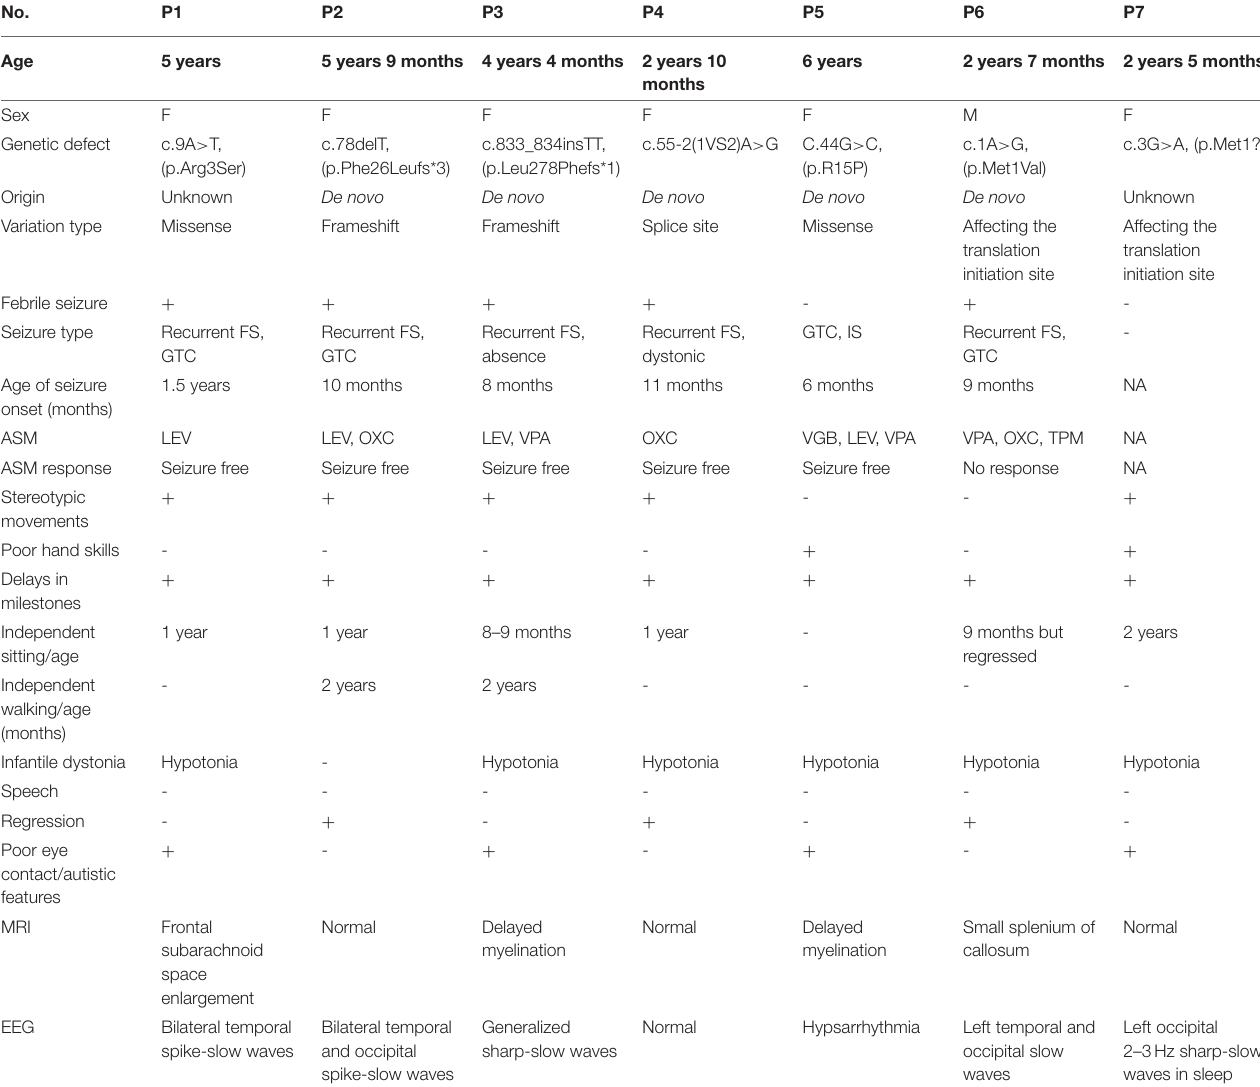
TABLE 1 | Clinical phenotype of patients with MEF2C gene mutation. No. P1